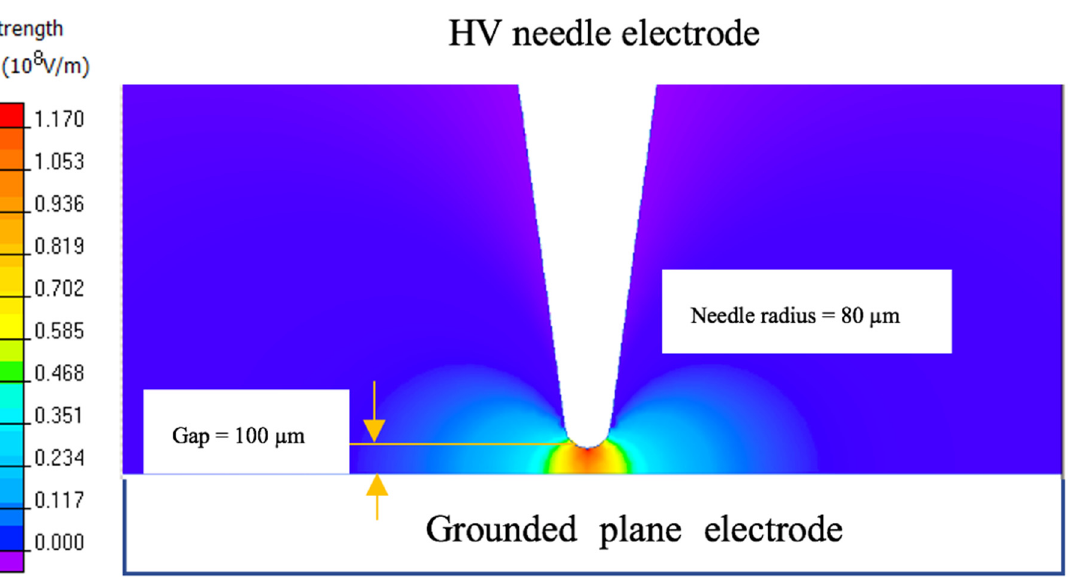
Figure 6. The magnitude of the electric field in the needle-plane topology. The radius of the needle is 80 µm, the gap spacing is 100 µm. The needle is stressed with 10 kV.